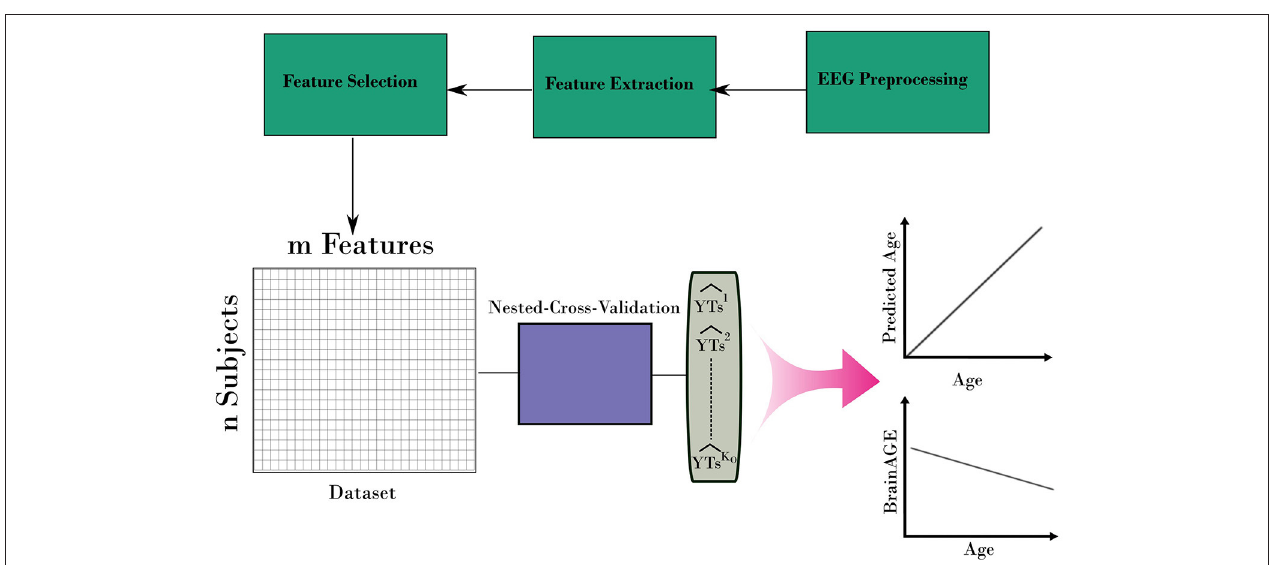
FIGURE 3 | The complete framework for estimating the BrainAGE form EEG. The framework uses the nested-cross-validation method ( Figure 2 ) to build estimation for the age. Then, those estimations are used to calculate the BrainAGE from the entire dataset.